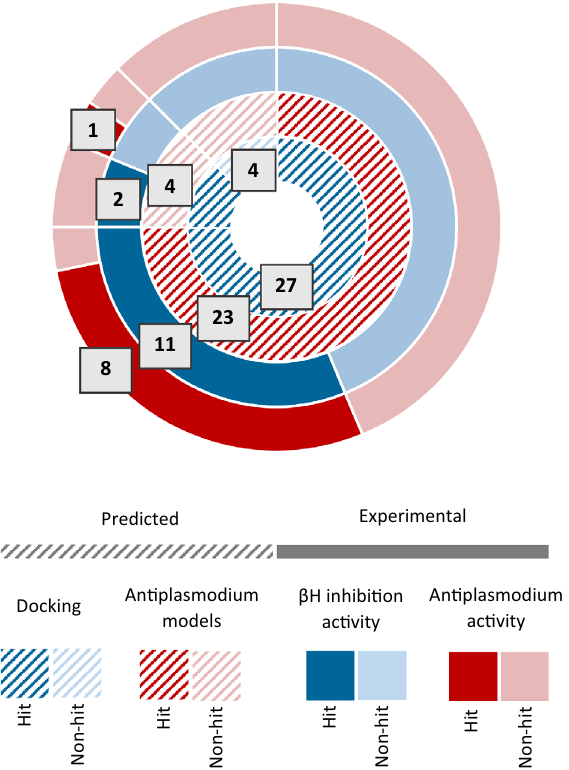
Figure 3. Graphic representation of the computational and experimental results for 31 compounds purchased from